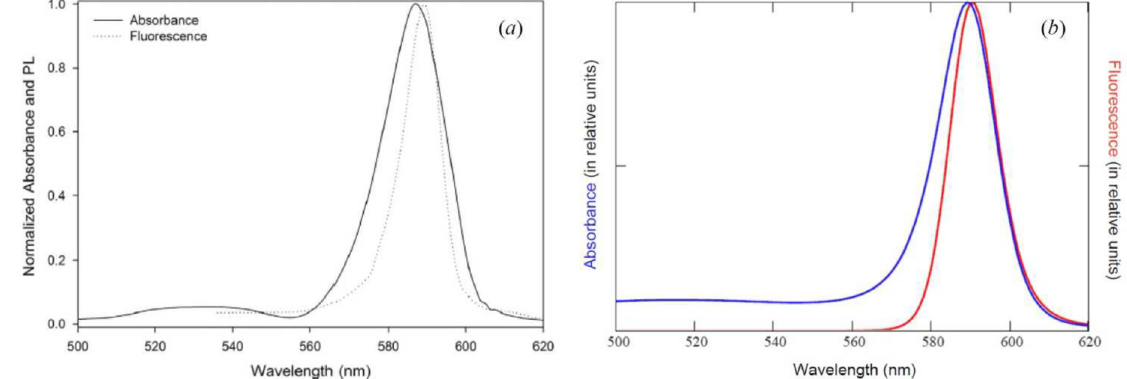
Figure 11. Comparison of theory with experiment for J-aggregates in Langmuir films. ( a ) Experi- mental absorption and fluorescence J-bands [86] shown in Figure 9a. ( b ) Theoretical absorption and fluorescence J-bands [6], fitted to the experimental data [86] (see ( a )). The fluorescence J-band is asymmetric to the absorption J-band and obtained from the latter by changing the sign both in the heat energy ∆ and in the J-chromophore length L , and increasing the energy gap J 1 − J 2 = 1.19 eV by 0.785 eV in order for the Stokes shift to be 1 nm (cf. Figure 9b). The rest of the fitting parameters are the same as those in Figure 9b.